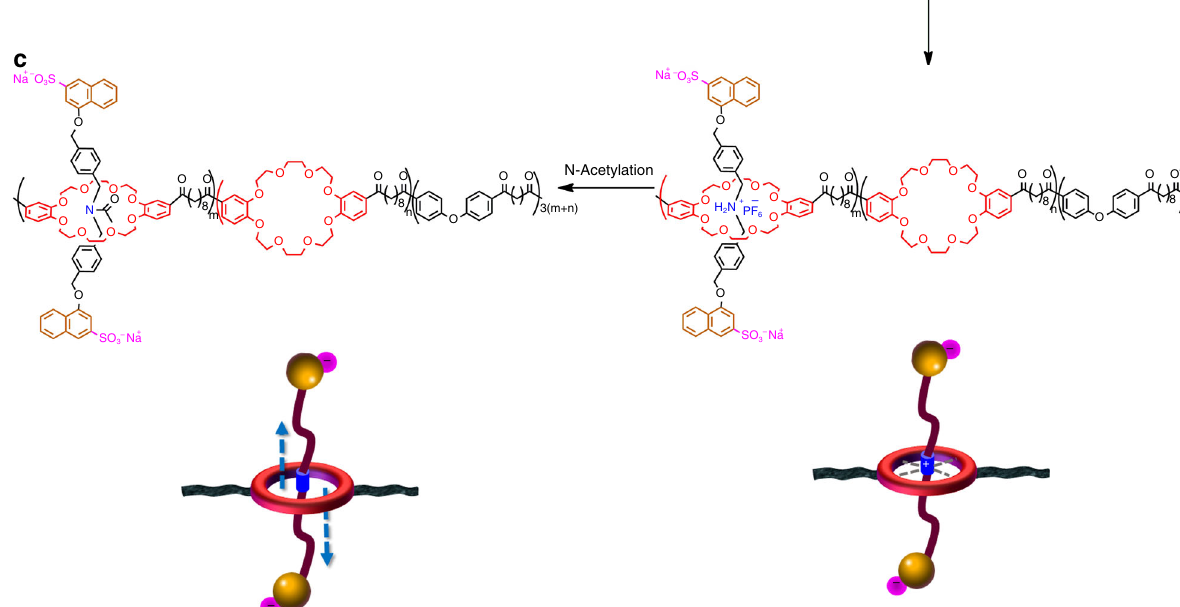
increased weight of dry membrane samples after immersion in DI water at certain temperature for 24 h) indicates that, in average, each 58 water molecules at 60 °C (Table 1). Despite the amount of water